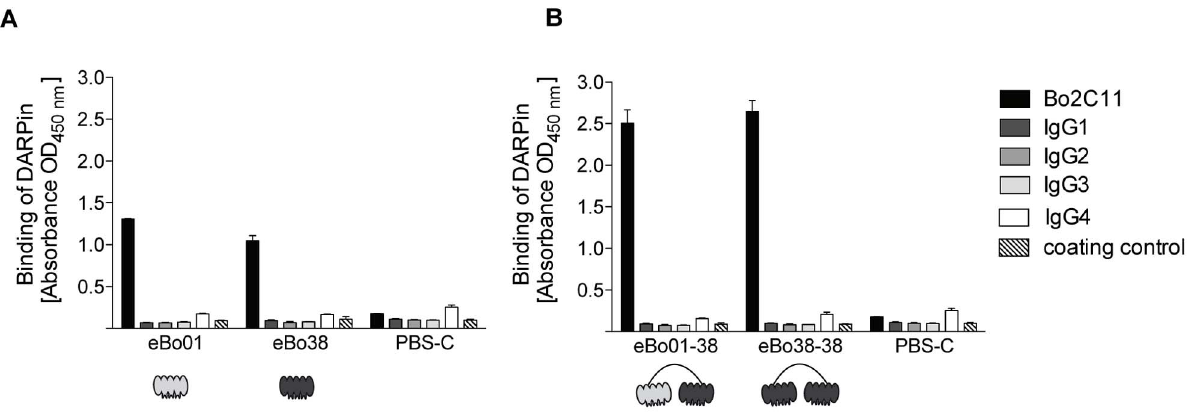
Figure 3. Specificity analysis of selected DARPin clones by ELISA. Purified DARPin proteins were tested for binding to the human monoclonal anti-FVIII antibody Bo2C11 (black bars), human IgG subclass antibodies of non-relevant specificity (IgG1 dark grey bars, IgG2 grey bars, IgG3 light grey bars, IgG4 white bars) and the coating control (PBS containing 0.15% Casein) (striped bars) in ELISA. DARPin binding was revealed using a monoclonal mouse antibody directed against the N-terminal RGS-His 6 -tag of DARPins and a horseradish-peroxidase-labeled goat anti-mouse antibody. A) shows the binding of 150 nM of monomeric DARPins eBo01 and eBo38. B) shows the binding of 4 nM of dimeric DARPins eBo01-38 and eBo38-38. As control in A) and B), PBS-C was incubated without DARPins on the human